Question: What type of chart is this?
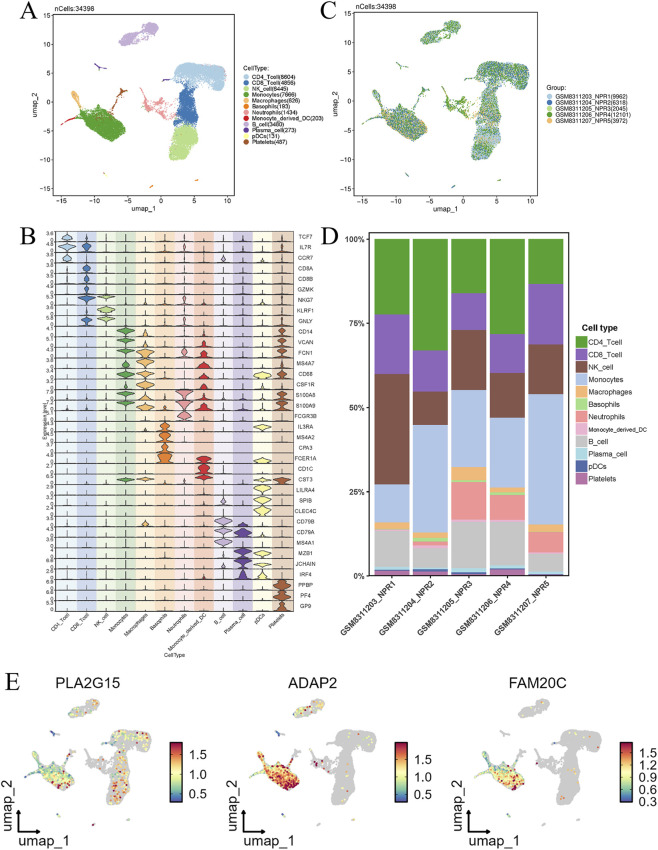
Answer: scatter